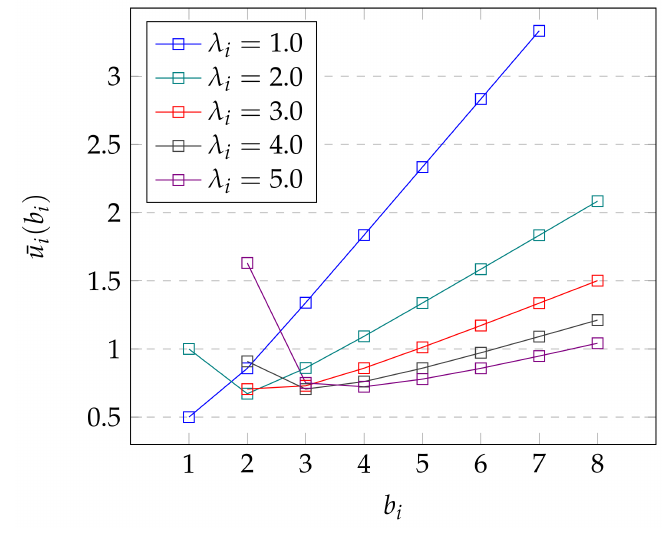
Figure 5. Average sojourn times in the node S i for µ i =